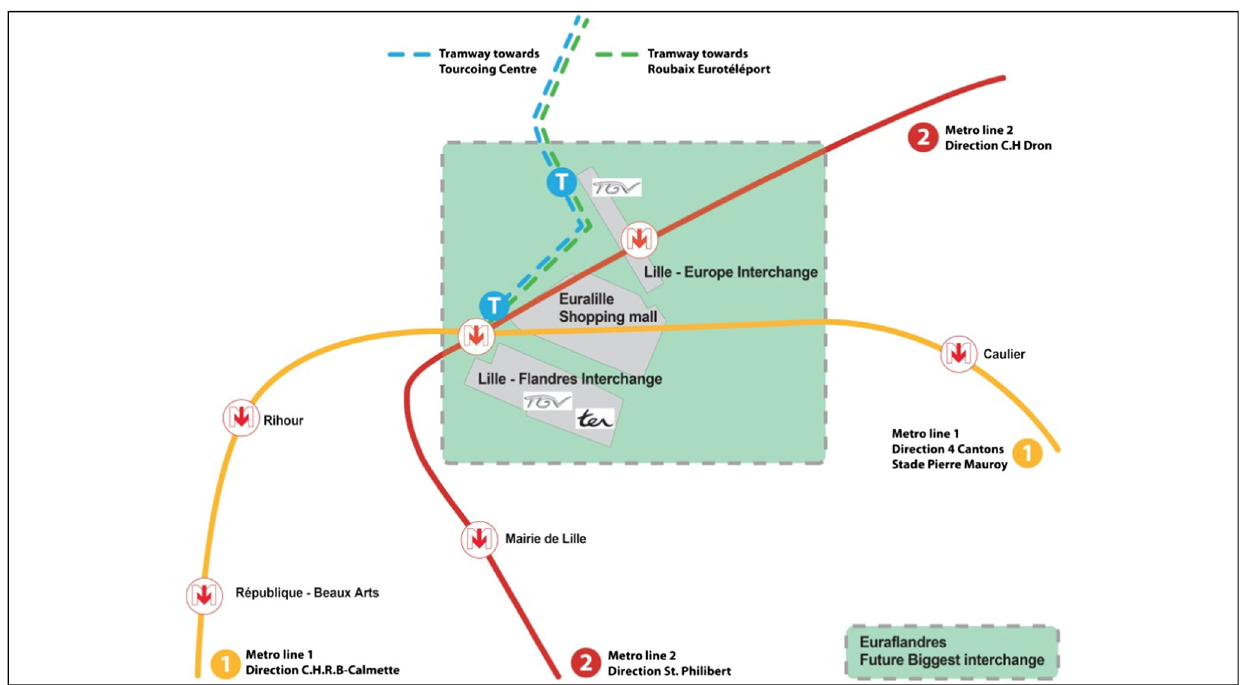
Fig. 3 B Euraflandres ^ : linking the B Gare Lille Flandres Interchange ^ and B Gare Lille Europe Interchange ^ (train, metro and tramway lines) within the B EuralilleCBD ^ . Source: Scheme D. Bourbotte, Ifsttar based on Gares & connexions SNCF, spl Euralille [16], SCOT